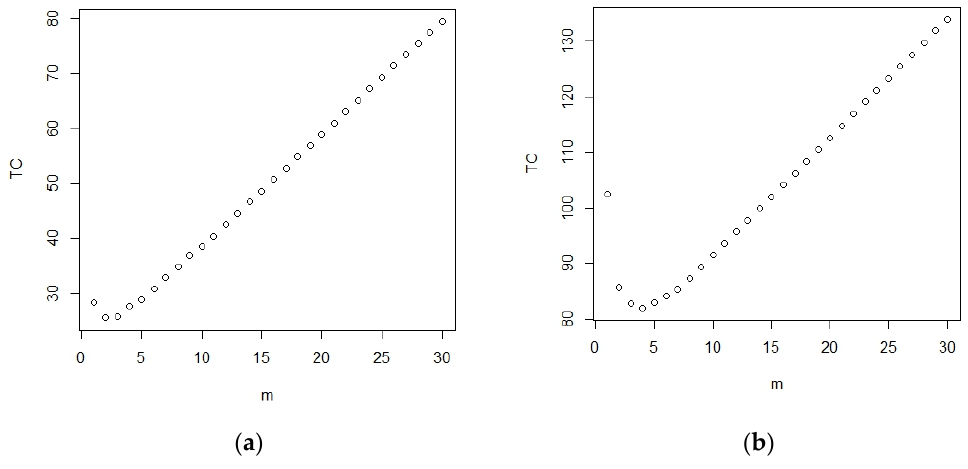
Figure 6. ( a ) The minimum total cost at m = 1: m 0 . ( b ) The minimum total cost at m = 1: m 0 . For testing H 0 : C L ≤ 0.8, the required minimum inspection intervals m* , the inspection interval time length t* , and sample size n* to yield the minimum total cost TC ( m* , t* ) are tabulated in Tables A3 and A4 at α = 0.01, 0.05, 0.1, β = 0.25, 0.20, 0.15, p = 0.01, 0.025, 0.05, 0.15, 0.25 for c 1 = 0.825, 0.85, and c 1 = 0.875, 0.90, respectively, under the constraint